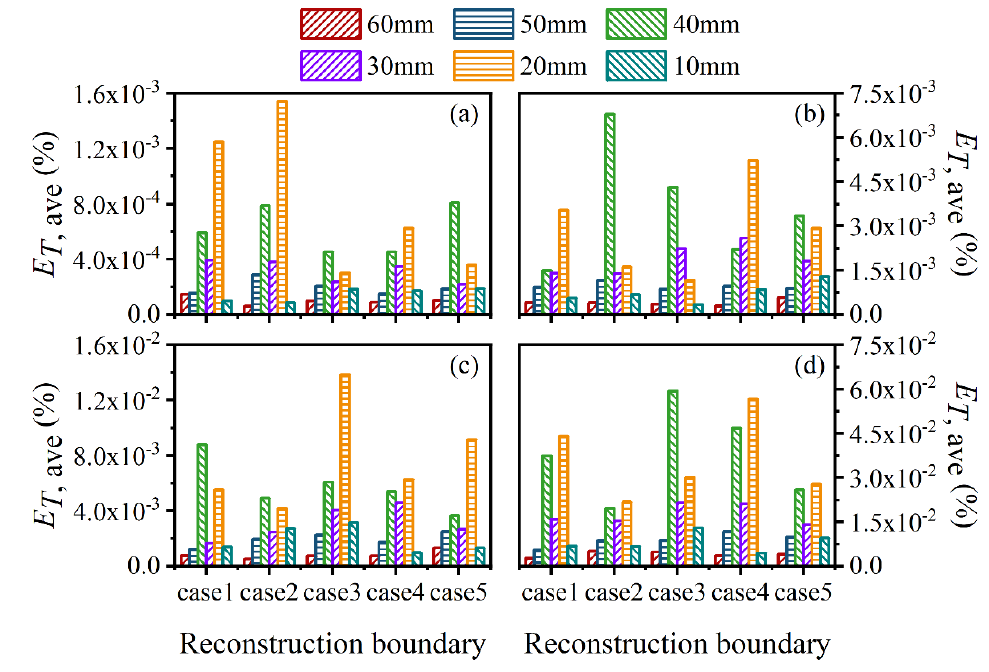
Figure 22. The average relative reconstruction error for temperature with different SNR considering different reconstruction boundaries. ( a ) SNR = 80 dB; ( b ) SNR = 65 dB; ( c ) SNR = 60 dB; ( d ) SNR = 46 dB.